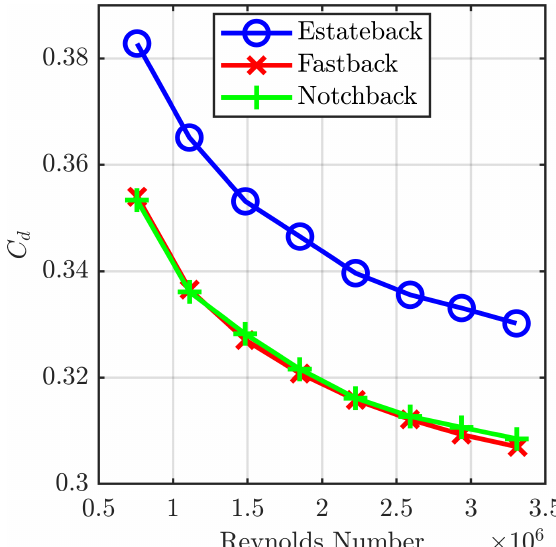
Figure 5. Reynolds sweep for the drag coefficient for each DrivAer